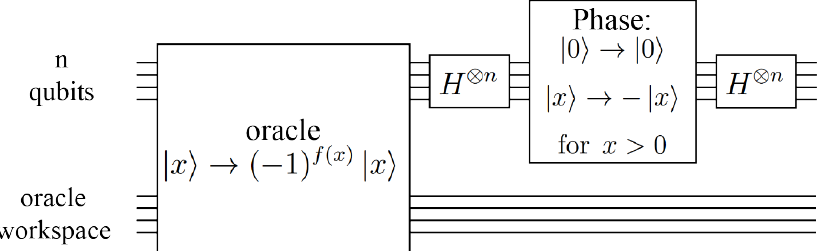
Figure 5. Schema of the circuit for a single Grover iteration, as described in [21]. First, the U ω oracle is applied in order to mark the solutions of the problem, then, the diffuser U ψ performs the reflection about the | ψ (cid:105) vector through a conditional phase shift, sandwiched between two Hadamard transforms. The oracle workspace register contains additional qubits that may be needed to perform the computation in the search